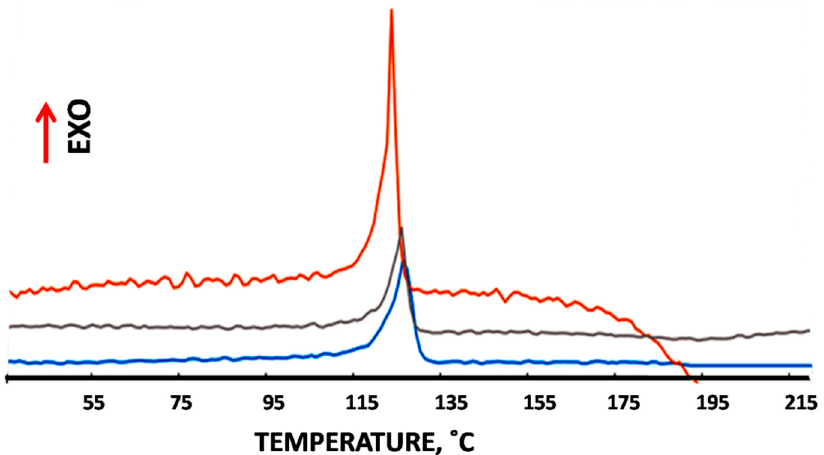
Figure 5. The DSC curves for mesoporous HDPE membrane (blue) and MP HDPE membranes after ozonation for 600 s (grey line) and 25,200 s (orange line). Red arrow shows the direction of exothermic effect.